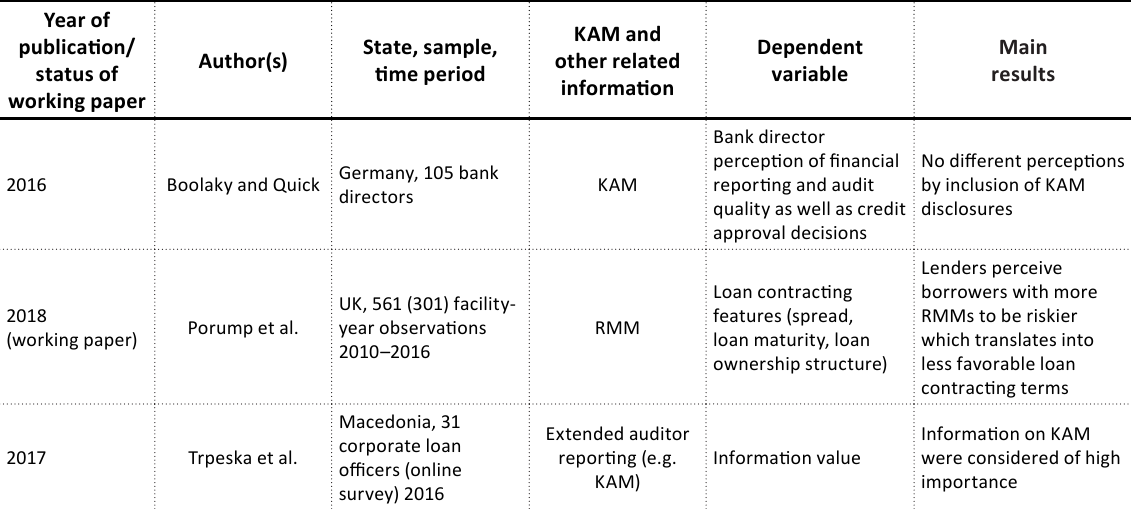
Table 4. Overview of empirical research regarding the impact of KAM and other related information on